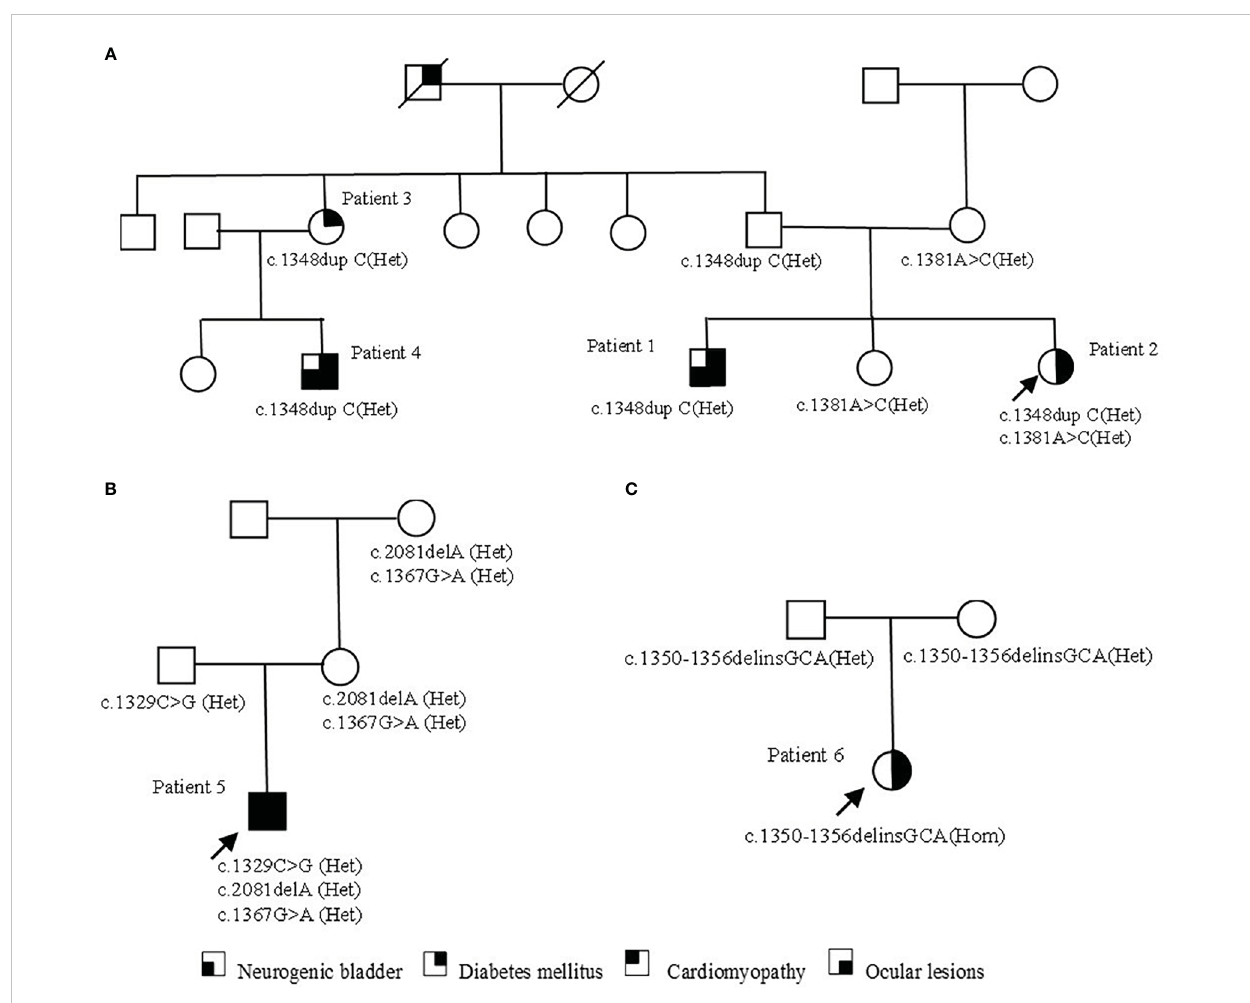
FIGURE 2 Pedigrees of families with WFS1 variants. (A) The pedigree of family 1. Patient 1 and cousin (Patient 4) carry the same pathogenic variation and have similar clinical symptoms. Patient 3 only shows non-insulin-dependent diabetes; patient 2 carries two heterozygous variants, with a light clinical phenotype. (B) The pedigree of family 2. In addition to typical diabetes, optic atrophy, and neurogenic bladder, patient 5 also had a rare cardiomyopathy phenotype. Family members carrying the variant were asymptomatic. (C) The pedigree of family 3. The parents of patient 6 were heterozygous carriers and had no clinical symptoms at